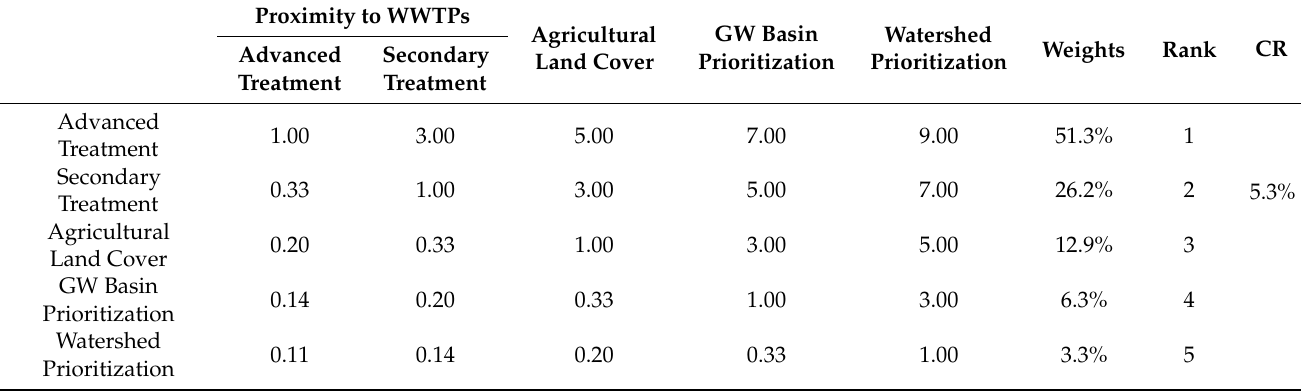
Table 5. Pairwise matrix for the decision criteria for Case 2: considering potential discharge capacity. Consistency Ration (CR) was calculated based on the Equation (1).